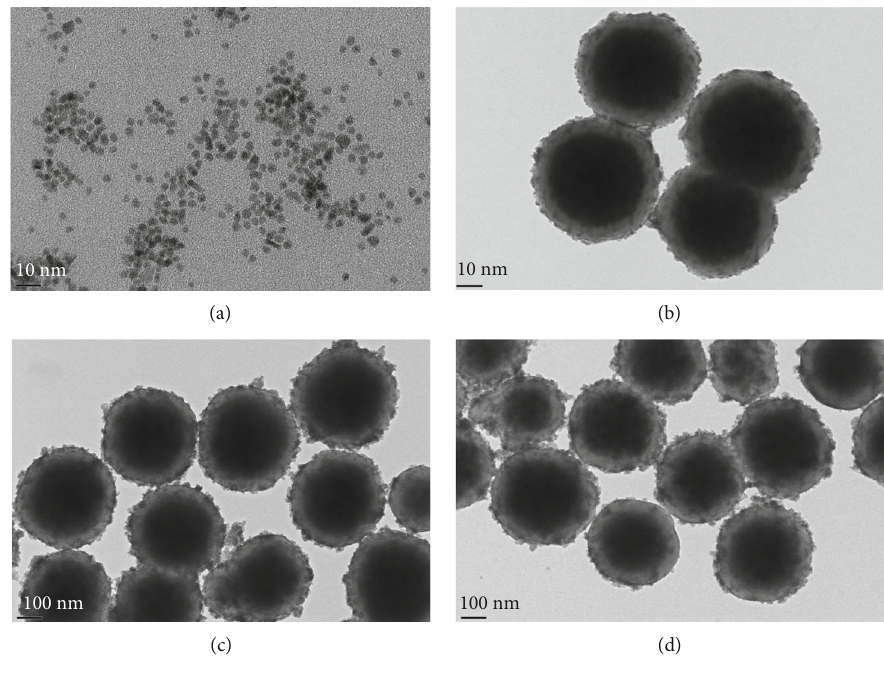
Figure 3: TEM images of (a) Ru NPs and (b – d) Fe